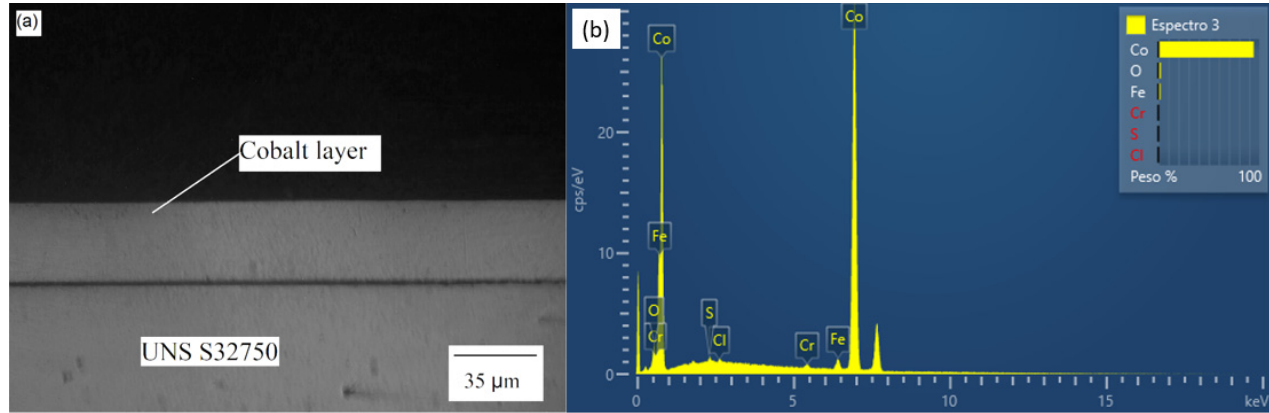
Figure 2. Co35 ( a ) Optical micrograph and ( b ) EDS diagram.